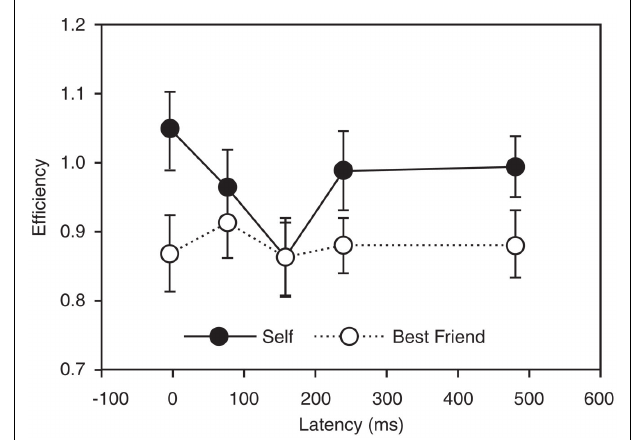
FIGURE 3 | Causality and specificity of one node of the paralimbic network in self-reference. The figure demonstrates the effects of applying transcranial magnetic stimulation (TMS) in targeting the precuneus/posterior cingulate region in a task probing self-reference.The causality of this region in self-reference is seen by the fact that retrieval of self-judgment was significantly less efficient withTMS at a latency of 160ms than with a latency of 0ms ( p = 0.003), suggesting that neural activity at that time interval after stimulus presentation is particularly important for self-representation. Specificity of this region in self-reference is provided by the fact that the difference between self and other (best friend) is significant at most latencies ( p < 0.05), except at the specific causal latency. (Lou et al., 2004, with